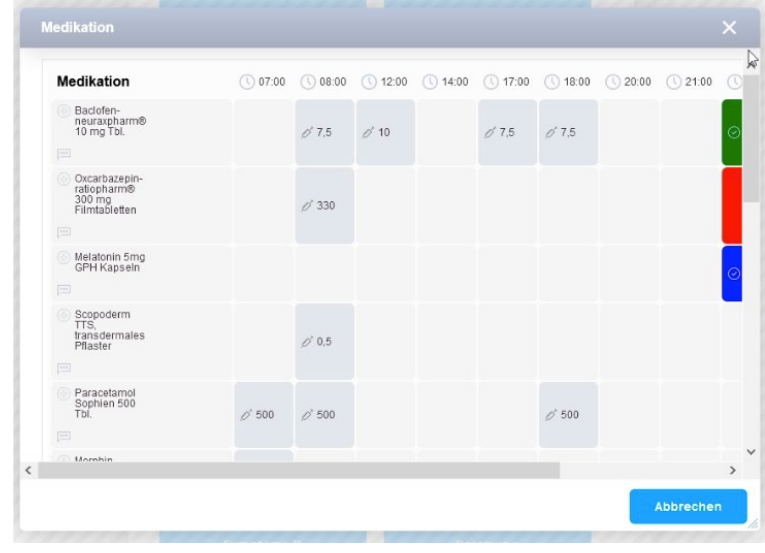
Figure 3. Plus-button menu in the patient chart module (ISPC/smart-Q).